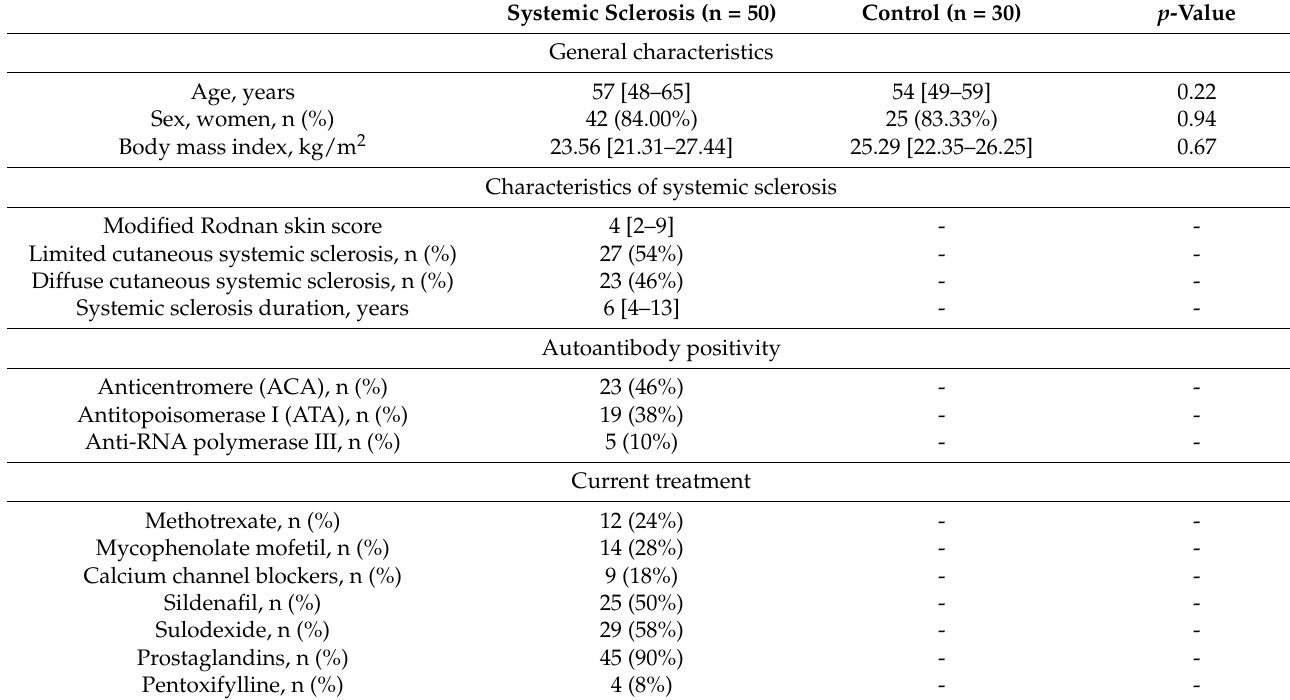
Table 1. The characteristics of the control group and individuals with SSc.